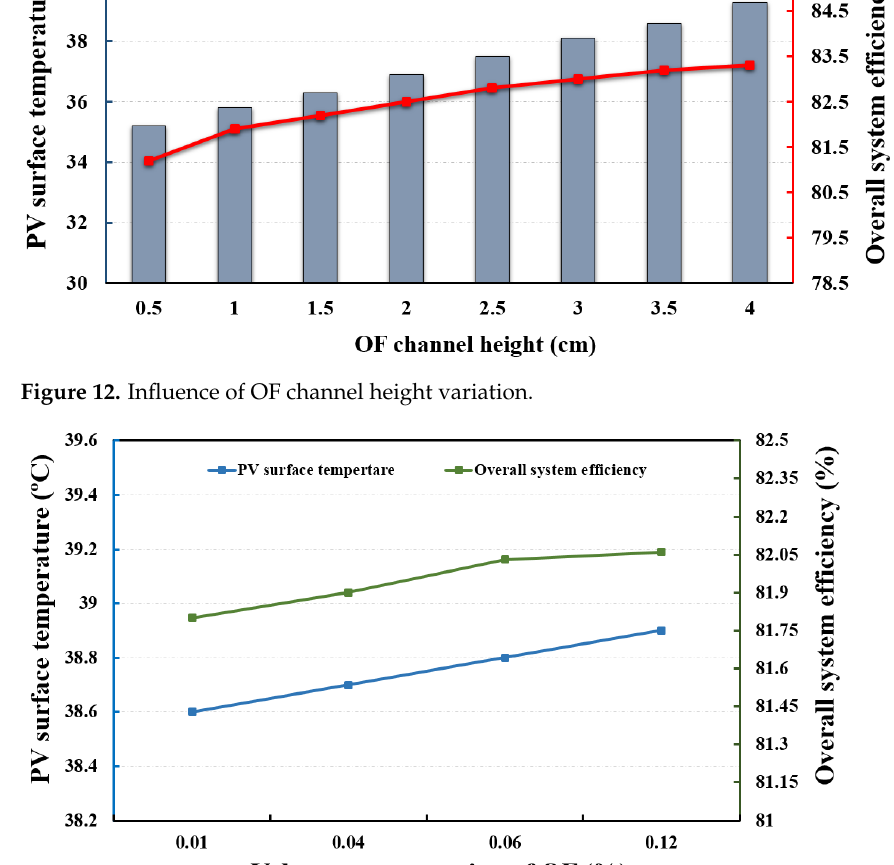
Figure 13. The effect of the OF channel height on the temperature of PV the module.